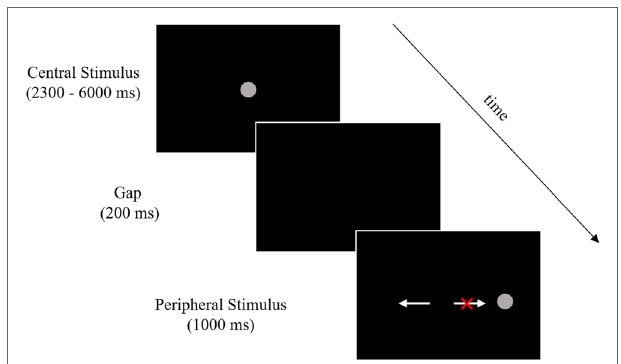
FigUre 1 | Stimuli and timing. Participants performed 120 trials across two runs of an antisaccade task (60 trials per run). The above image outlines a single trial, which began with a central stimulus. Central stimulus timing was pseudorandomly jittered between 2,300 and 6,000 ms in order to deconvolve the stimulus-related hemodynamic response in the rapid event-related design. A 200-ms gap was then introduced followed by the peripheral stimulus presentation. Participants were given 1,000 ms after the peripheral stimulus onset to execute a glance in the opposite direction. The white arrow pointing to the left indicates a correct response (a glance to the mirror image of the peripheral stimulus) and the white arrow pointing to the right with the red “X” indicates an error response (a glance toward the peripheral stimulus). Arrows and the red X were not present during the